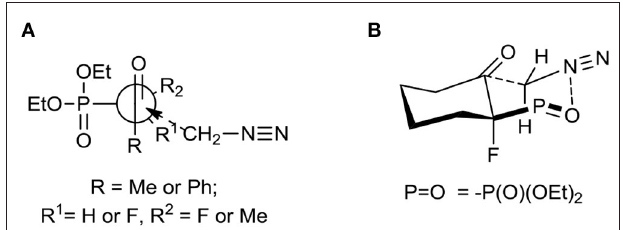
FIGURE 3 | (A) Unhindered attack of CH 2 N 2 to β -ketophosphonates 1 – 3 during formation of 5–7 ; (B) Proposed transition state leading to 8 .